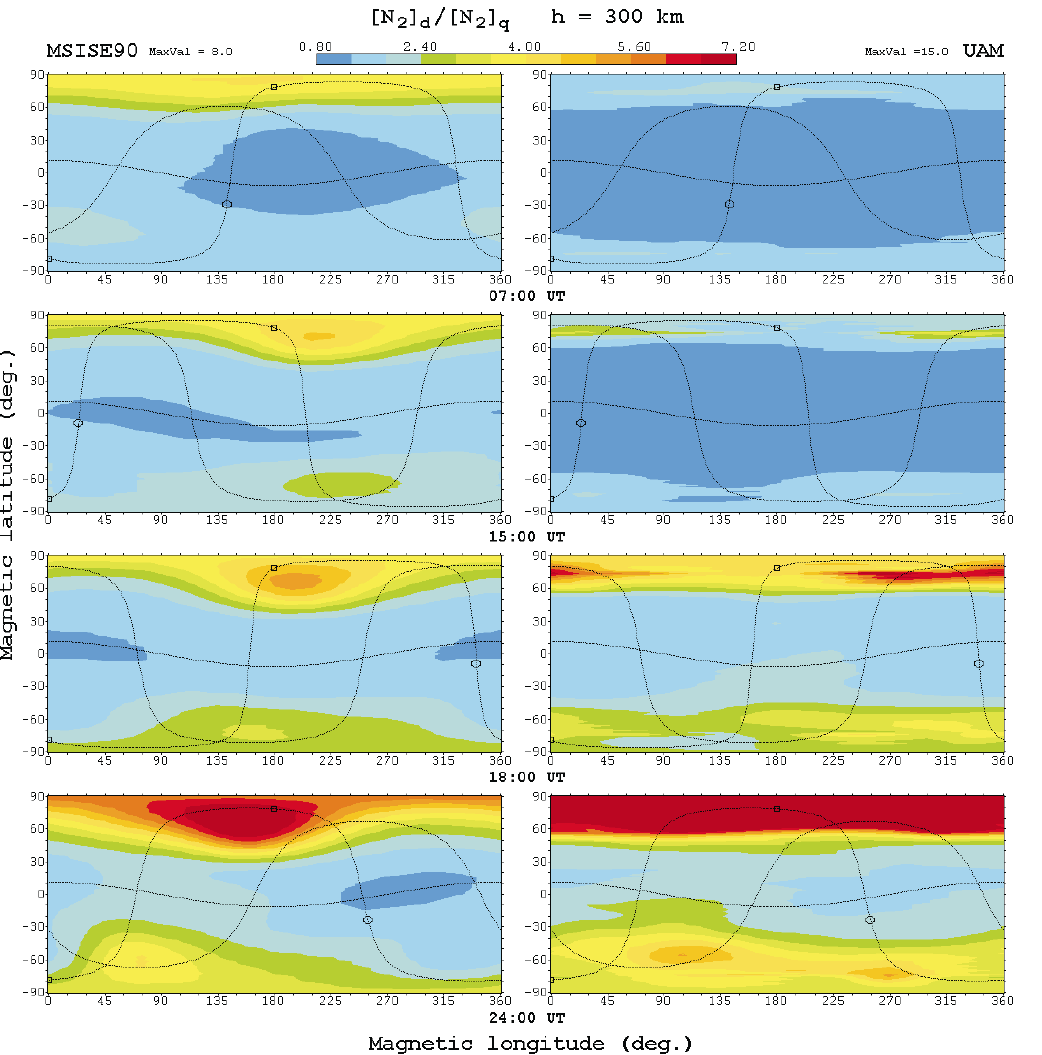
Fig. 3. The same as in Fig. 2 but for the molecular nitrogen concentration disturbance (storm to quiet concentration ratio R (N